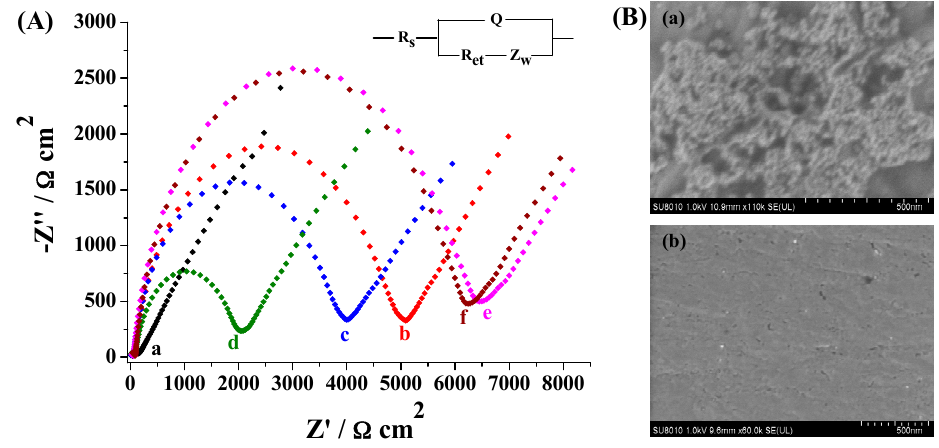
Figure 4. ( A ) Electrochemical impedance spectroscopy (EIS) of the bare electrode (curve a) and peptide/6-mercapto-1-hexanol (MCH)-modified electrode before (curve b) and after incubation with AuNPs (curve c) or AuNPs/peptide (curve d). Curve e corresponds to that after incubation with DPP-IV only. Curve f corresponds to that of incubation with AuNPs/peptide following the incubation with DPP-IV. The final concentrations of AuNPs, peptide and DPP-IV were 1.8 nM, 0.4 µ M and 5 mU/mL, respectively; ( B ) SEM images of peptide/MCH-modified electrode incubated with AuNPs/peptide before (panel a) and after treatment (curve b) by DPP-IV.